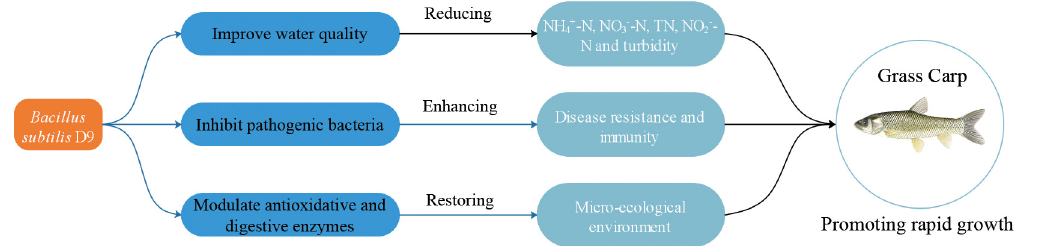
Fig. 4. Proposed mechanisms of Bacillus subtilis D9 affecting disease resistance of grass